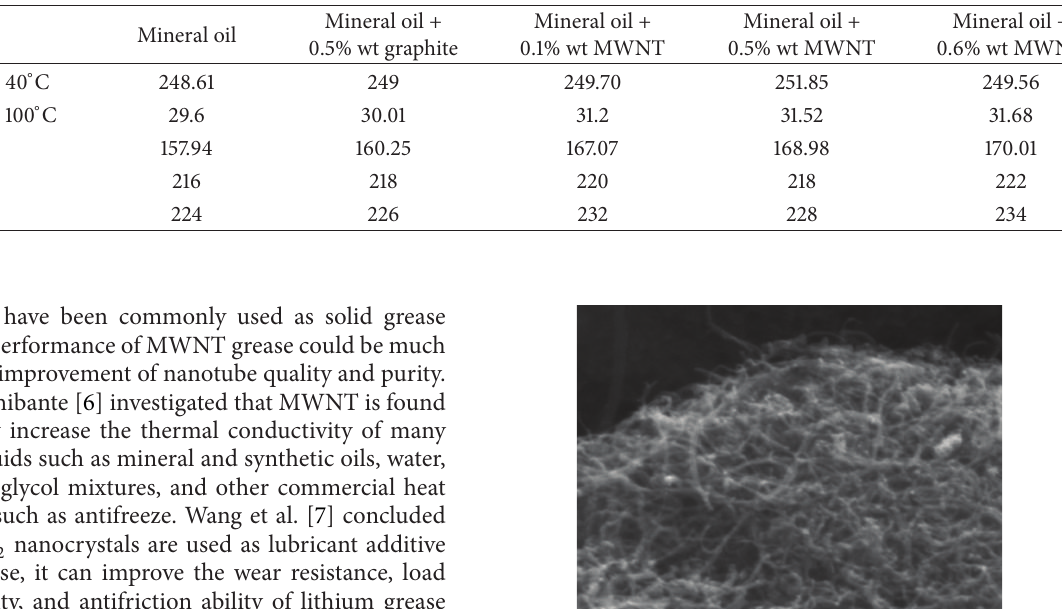
Table 1: Properties of the lubricants.